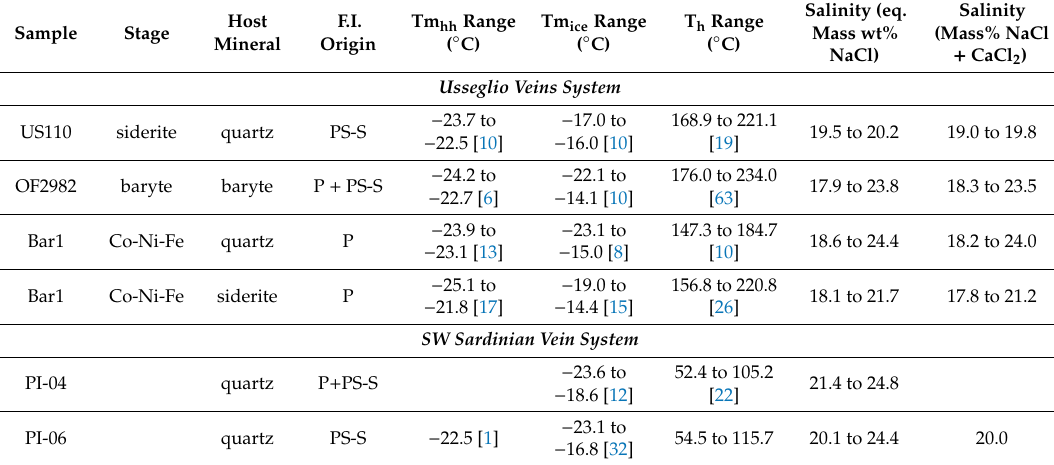
Summary of final ice melting temperature (Tm ice ), homogenization temperatures (Th), hydrohalite melting temperature (Tm hh ) data and computed salinity for primary (P) and pseudosecondary–secondary (PS–S) fluid inclusions from the Usseglio and SW Sardinian vein systems. Number of measurements are reported within